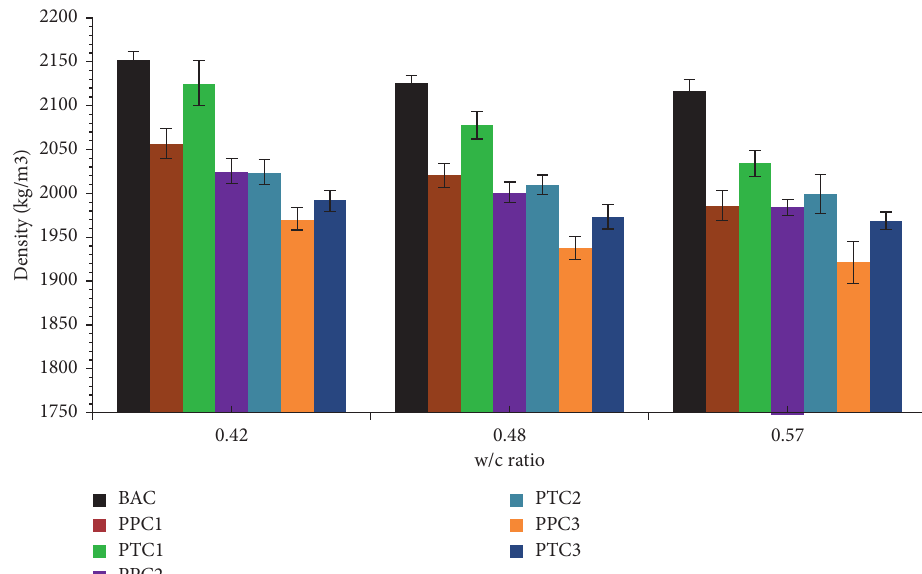
Figure 4: Variation of density with w/c ratio for various concrete aggregates.